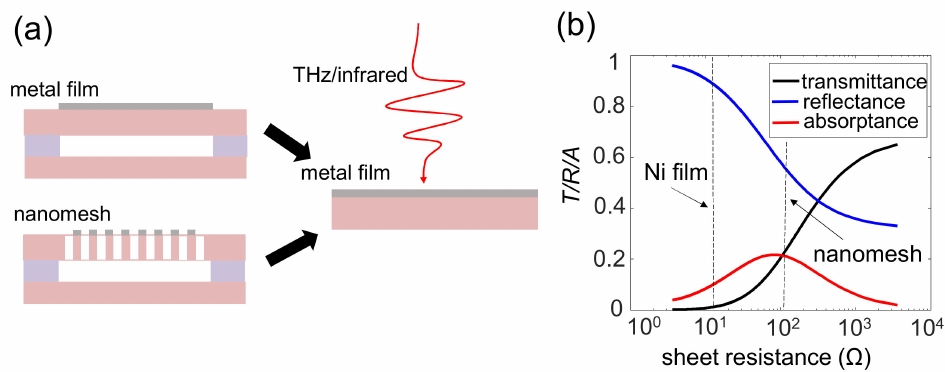
Figure 5. ( a ) The schematic structure applied to a metal film as a light absorber in buck MEMS and MEMS bolometers with a porous nanomesh. When the wavelength of light (THz/infrared) was much larger than the featured size of the nanomesh, the absorptance in both structures was treated as a simple metal film deposited on a supporting substrate. ( b ) The calculated transmission, reflection, and absorptance as a function of sheet resistivity for a simple metal film deposited on a substrate with a refraction index of n =